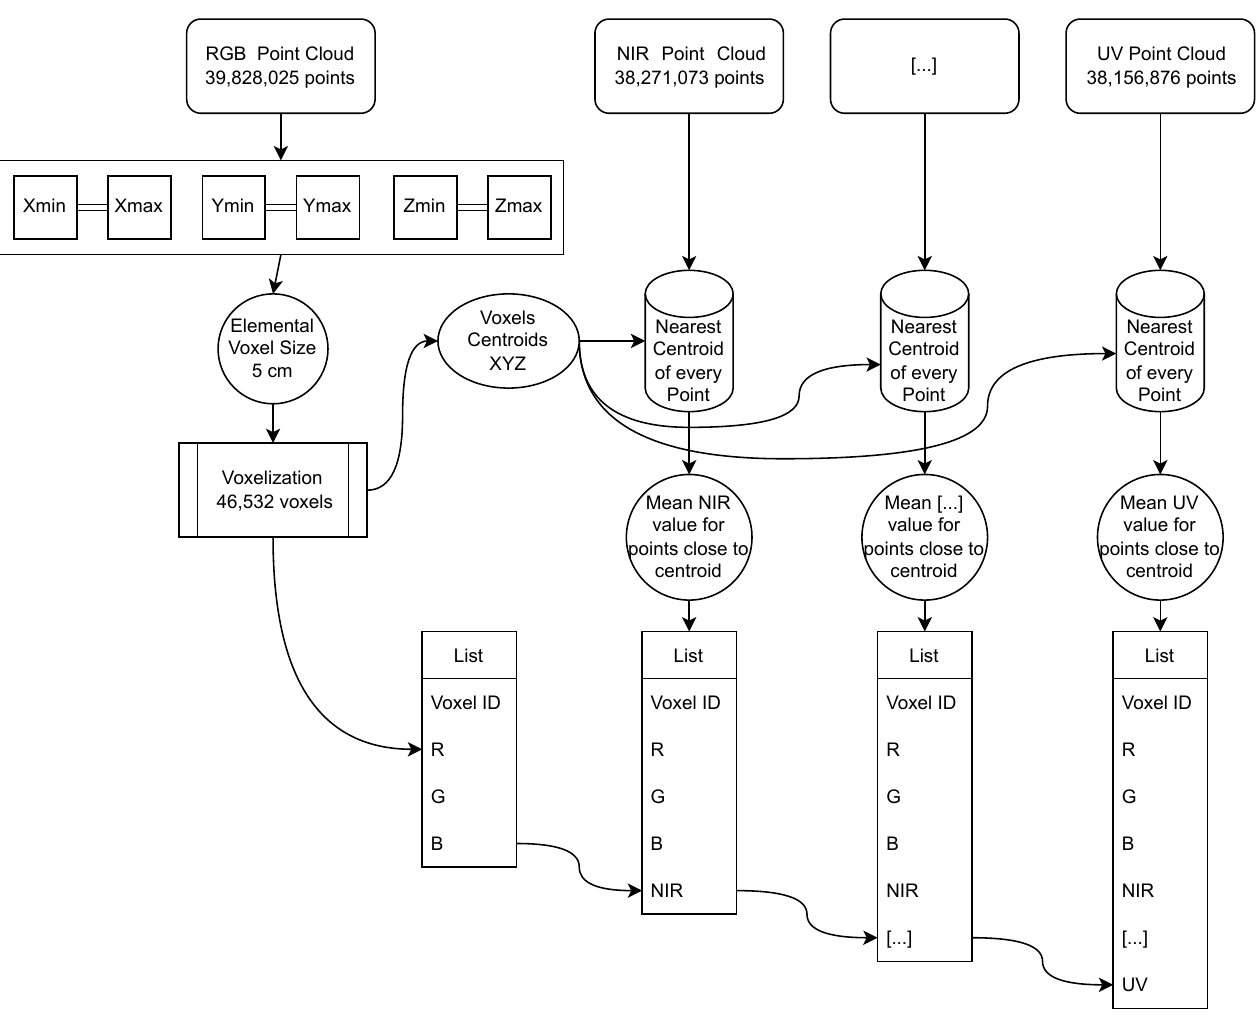
Figure 16. Point clouds voxelization fusion flowchart.